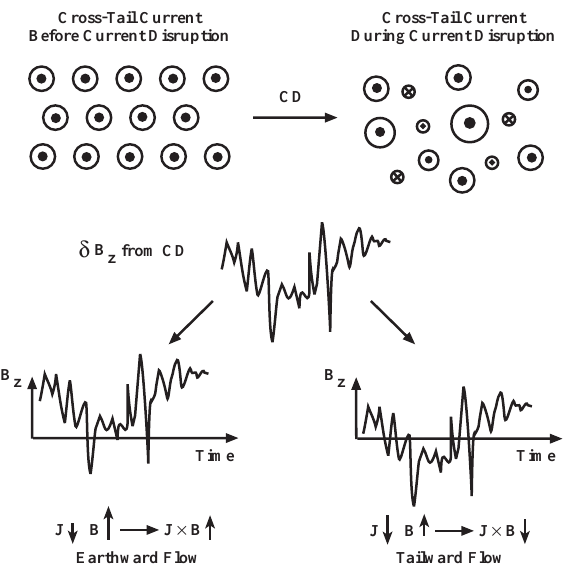
Fig. 6. Schematic of how small-scale fluctuations from localized current disruptions might lead to organized earthward or tailward flow. After Lui